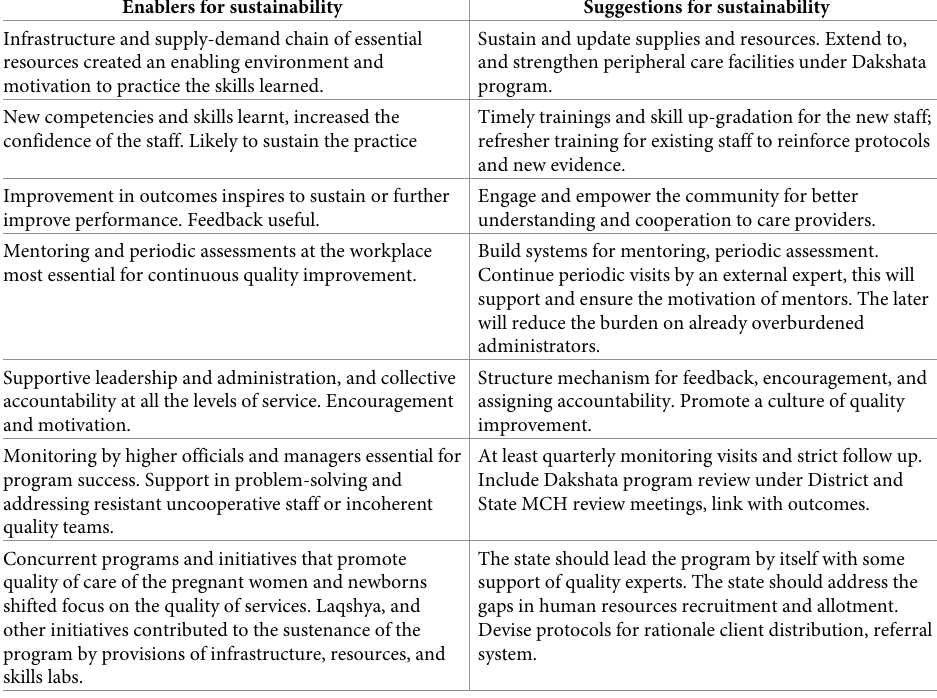
Table 4. Key enablers and suggestions for sustainability of Dakshata program as per the stakeholders. Enablers for sustainability Suggestions for